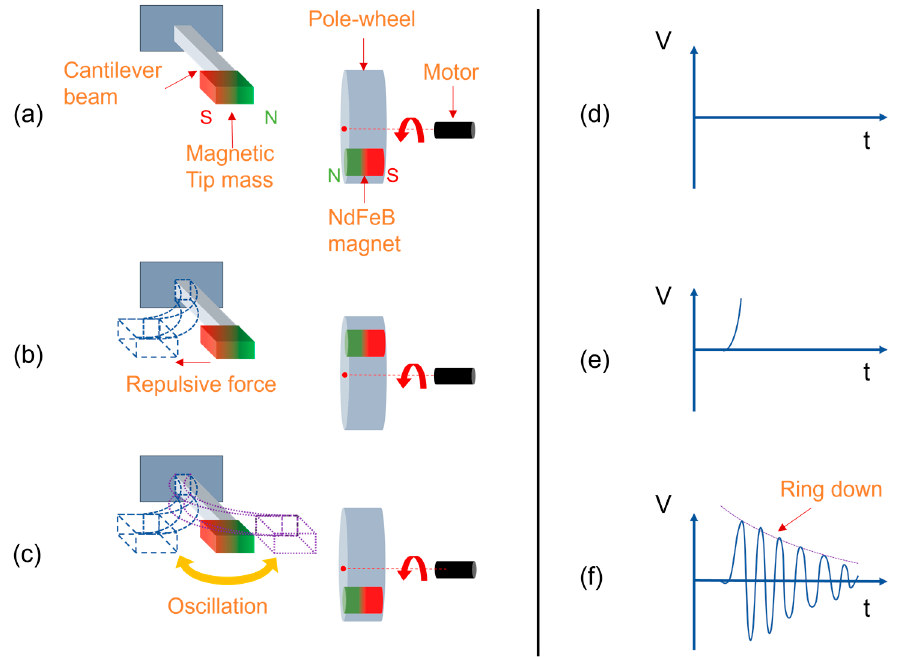
Figure 2. Illustration of the magnetic plucking-based frequency up-conversion scheme. ( a ) Pole- wheel magnet is far away before plucking, ( b ) magnet is at the closest distance to the tip mass during plucking, ( c ) the excitation magnet moves away from the harvester after plucking. ( d – f ) illustrate the voltage output of the harvester at the respective stages of plucking.